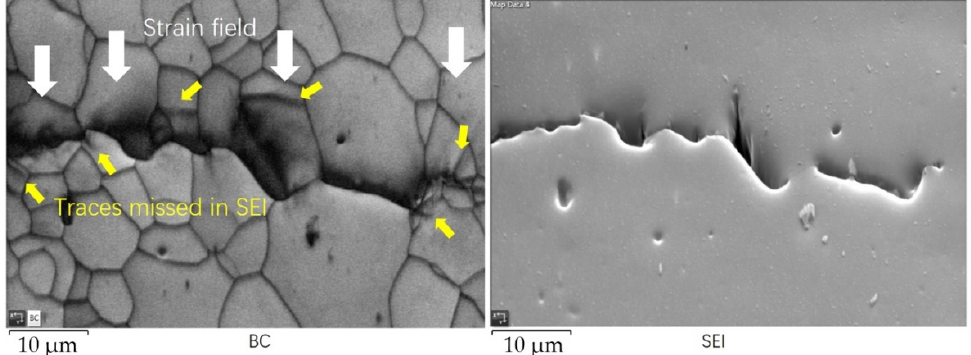
Figure 10. The BC map and SEI at the crack tip on the base metal.